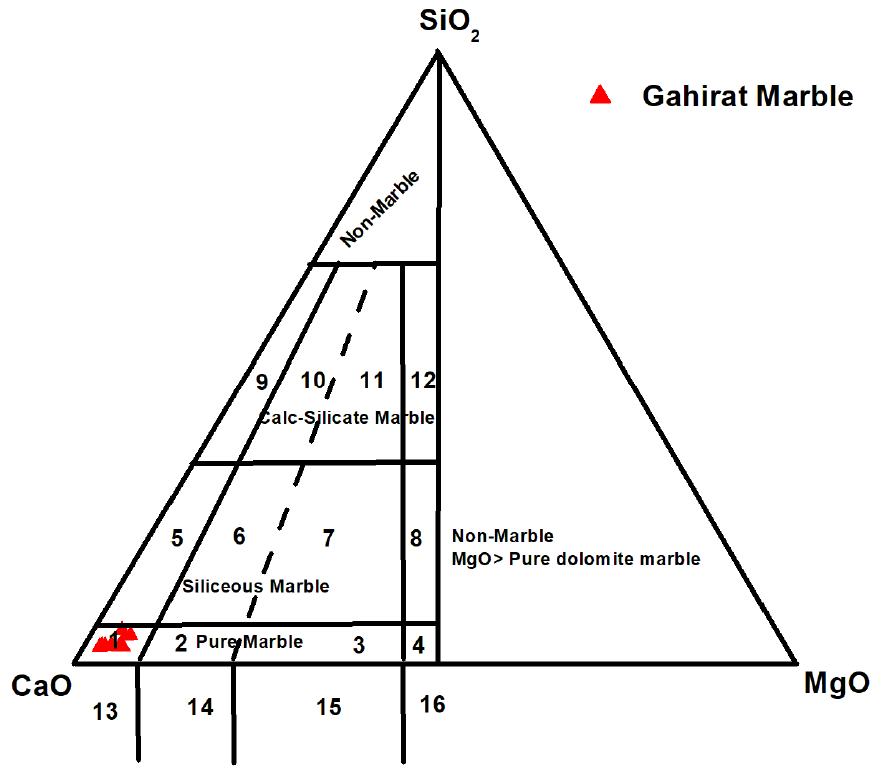
Figure 6. CaO-MgO-SiO 2 ternary diagram classification system for marbles and plots of studied samples. 1: pure calcite, 2: pure dolomitic calcite, 3: pure calcitic dolomite, 4: pure dolomite, 5: siliceous calcite, 6: siliceous dolomitic calcite, 7: siliceous calcitic dolomite, 8: siliceous dolomite, 9: calc–silicate calcite, 10: calc–silicate dolomitic calcite, 11: calc–silicate calcitic dolomite, 12: calc–silicate dolomite, 13: calcite marble, 14: dolomitic calcite marble, 15: calcitic dolomite marble, 16: dolomite marble non-marble and MgO > pure